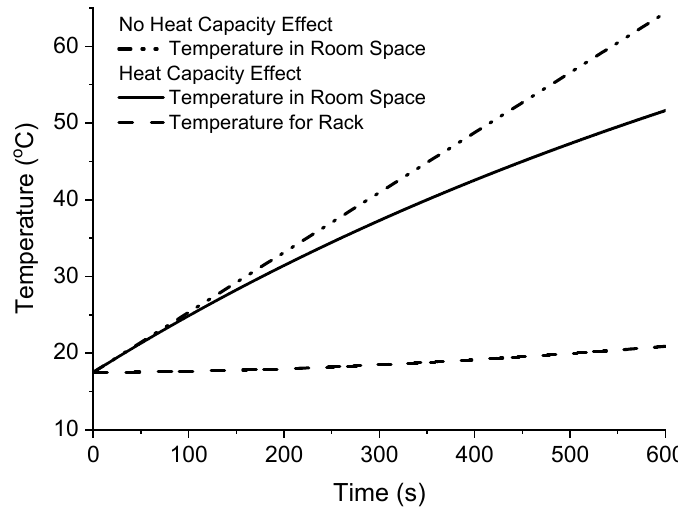
Figure 7. Variation of room air and rack temperatures over time.